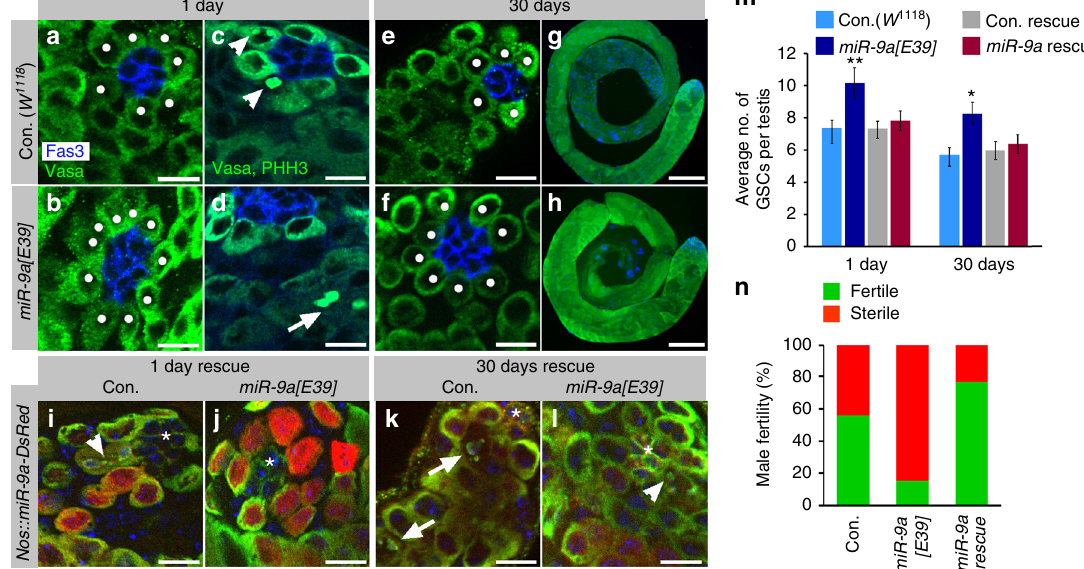
Fig. 2 miR-9a mutants increase GSCs maintenance but reduce spermatogenesis. a – h Testes from 1-day ( a , c ) or 30-days ( e , g )-old control ( w 1118 ) or 1-day ( b , d ) or 30-days ( f , h )-old miR-9a[E39] mutants immunostained for Fas3 ( blue , hub), Vasa ( green , germ cells), and with pHH3 ( green , c – d ). White dots denote GSCs. i – l Rescue of miR-9a[E39] mutants by ectopic expression of DsRed-miR-9a in GSCs and progenitor germ cells ( nos-GAL4 , UAS-DsRed-miR-9a ; miR-9a[E39] ), Con. rescue ( nos-GAL4 , UAS-DsRed-miR-9a ; miR-9a[E39] /TM6), young ( i ) and aged ( k ); Vasa, Fas3, and pHH3 ( green ) DsRed ( red ) and DAPI ( blue ). Asterisks mark the hub, arrowhead denote mitotic GSCs and arrow mitotic spermatogonia. Scale bars 10 µ m ( a – f , i – l ) and 100 µ m ( g – h ). m Shown are average number of GSCs per testis along with 95% con fi dence interval ( error bars ). The total number of testes scored: con. ( w 1118 ) 1-day ( n = 47), 30-days ( n = 60); miR-9a[E39] 1-day ( n = 71), 30-days ( n = 70); Con. rescue 1-day ( n = 45), 30-days ( n = 24); miR-9a[E39] rescue 1-day ( n = 33), 30-days ( n = 16); Statistical signi fi cance was determined as in Fig. 1d. ** P ≤ 0.005, * P ≤ 0.01 between miR-9a[E39] and the other three genotypes (Con. w 1118 , Con. rescue, and miR-9a [E39] rescue) of the same age. n Fertility assay of aged males (30 days) from control ( w 1118 , n = 36) and